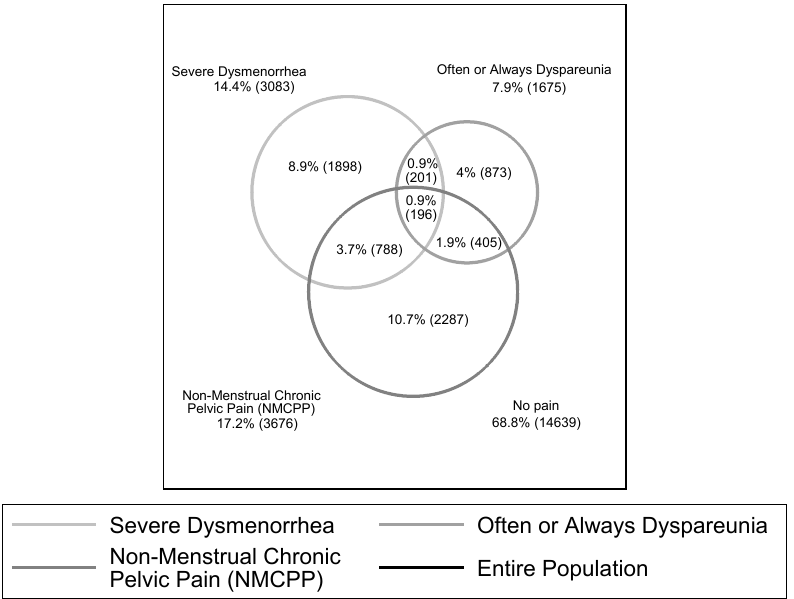
Figure 2. Proportional Venn diagram drawing overlapping relations between symptoms of the three types of chronic pelvic pain according to its severity (dysmenorrhea) or frequency (dyspareunia), n = 21,287.